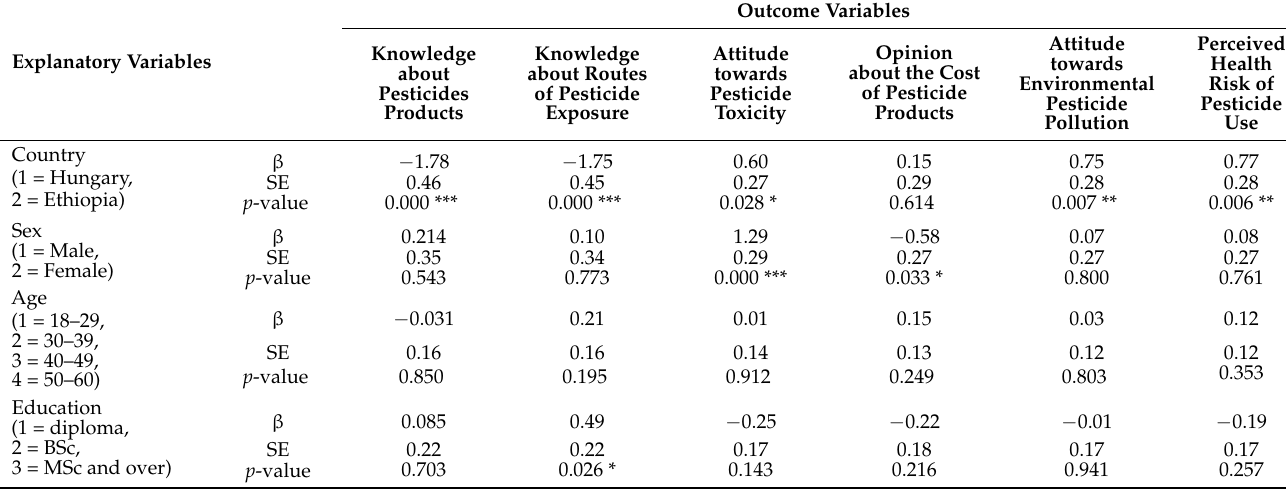
Table 6. Factors determining knowledge of and attitude to pesticide use among officers in Hungary and Ethiopia.